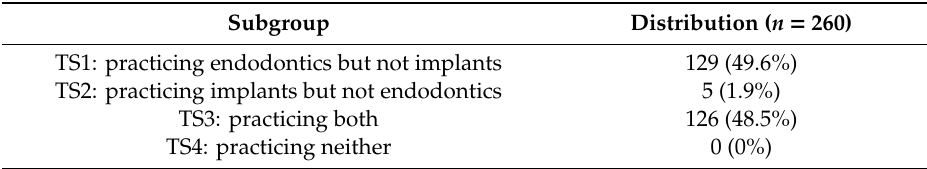
Table 2. Proportions of the four subgroups based on categories of treatment spectrum performed in the dental